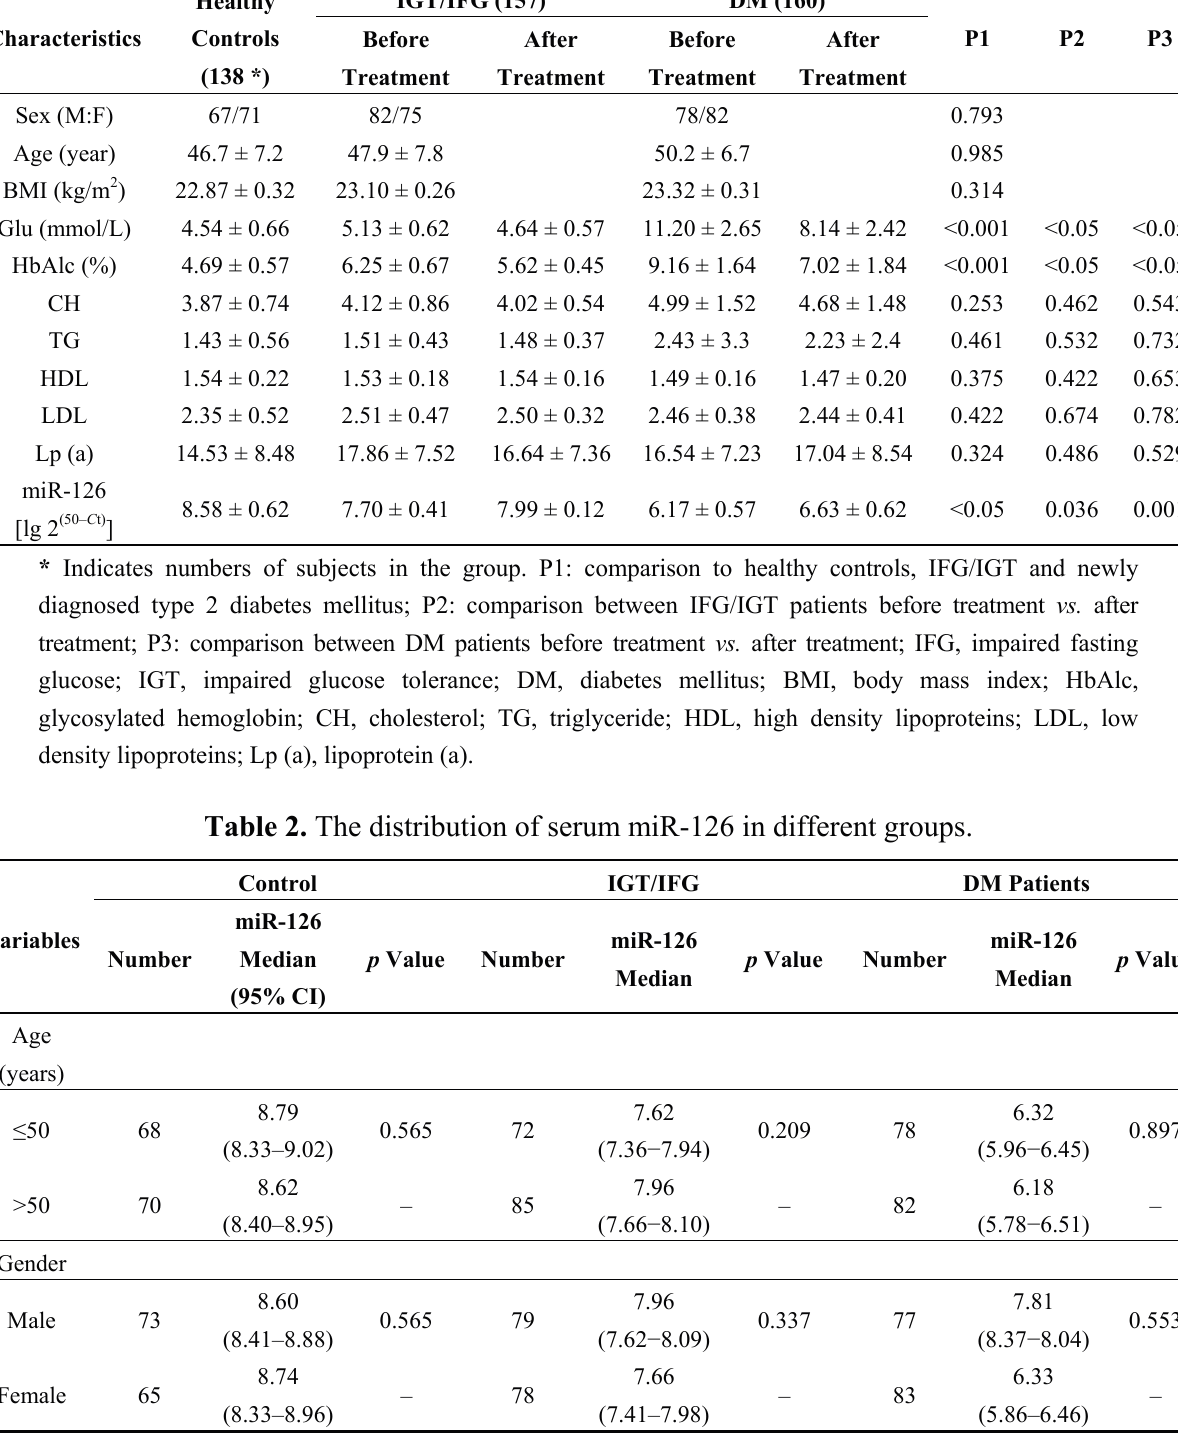
Table 1. Clinical characteristics for patients of impaired glucose tolerance (IGT)/impaired fasting glucose (IFG), diabetes mellitus (DM) and healthy controls. IGT/IFG (157) DM (160) Healthy Characteristics Controls After Before After (138 *) Treatment Treatment Treatment Treatment 67/71 82/75 78/82 0.793